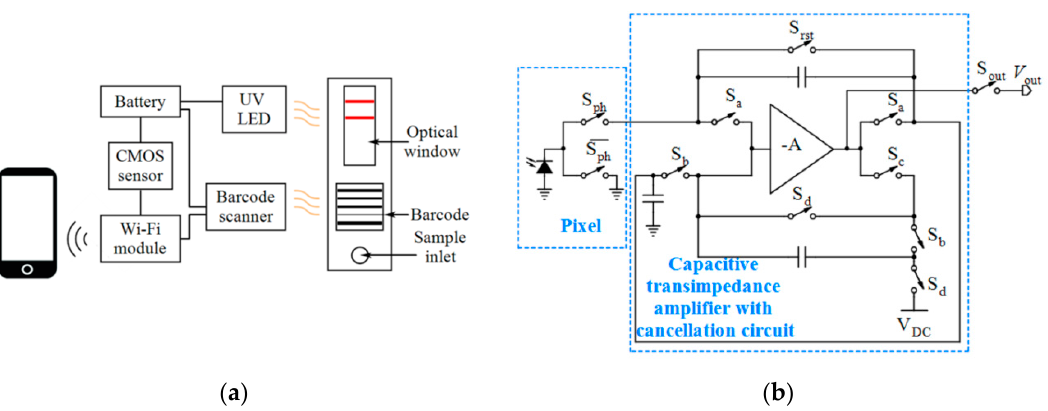
Figure 3. ( a ) Hardware structure of a strip reader, ( b ) The pixel and processing architecture of an LFIA reader.